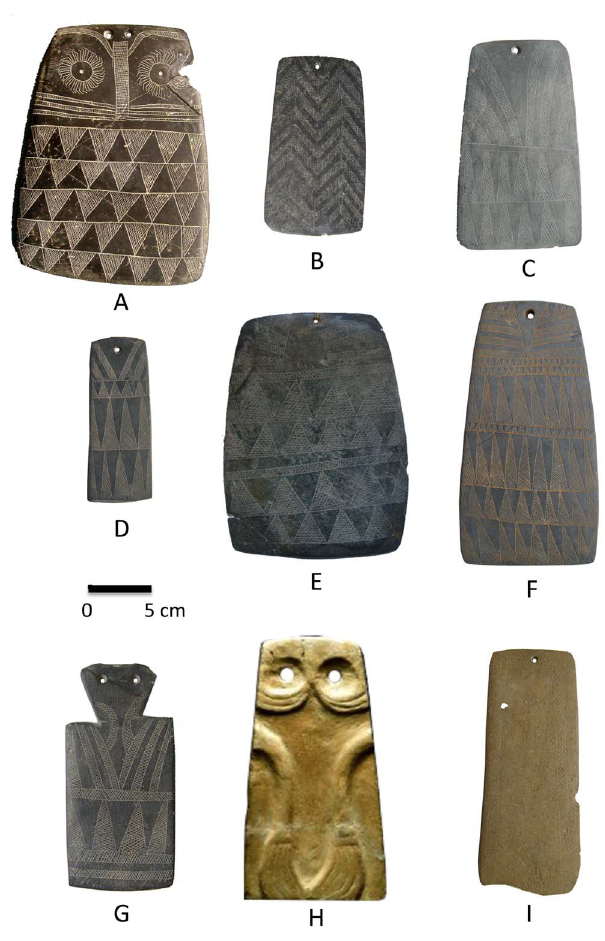
Figure 1. Engraved plaques from the Iberian Peninsula. a, Valencina de la Concepcio´n, Sevilla, Spain (Museo Arqueolo´gico de Sevilla [MAS]); b, S. Geraldo, Montemor-o-Novo, E´vora, Portugal (Museo Nacional de Arqueologia de Portugal [MNAP]); c, Monsaraz,